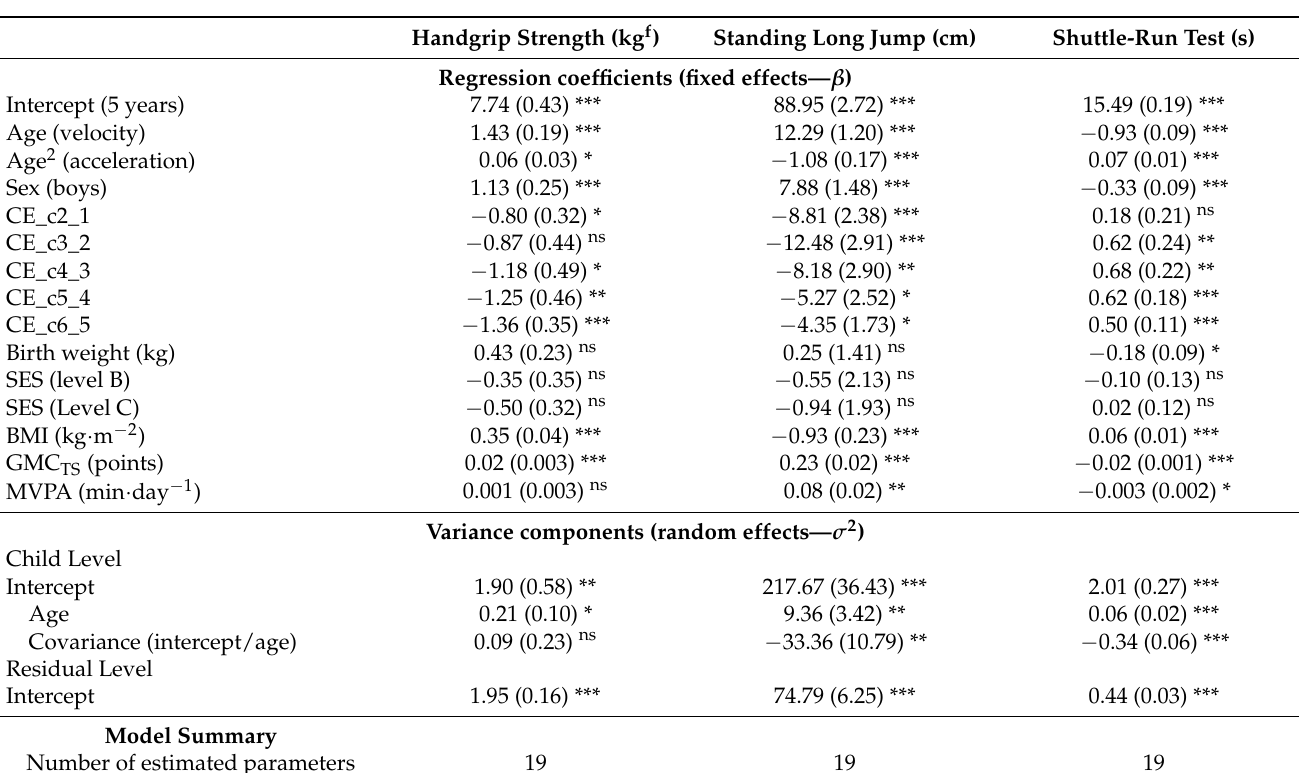
Table 4. Parameter estimates (standard errors) for fixed and random effects of the three multi- level